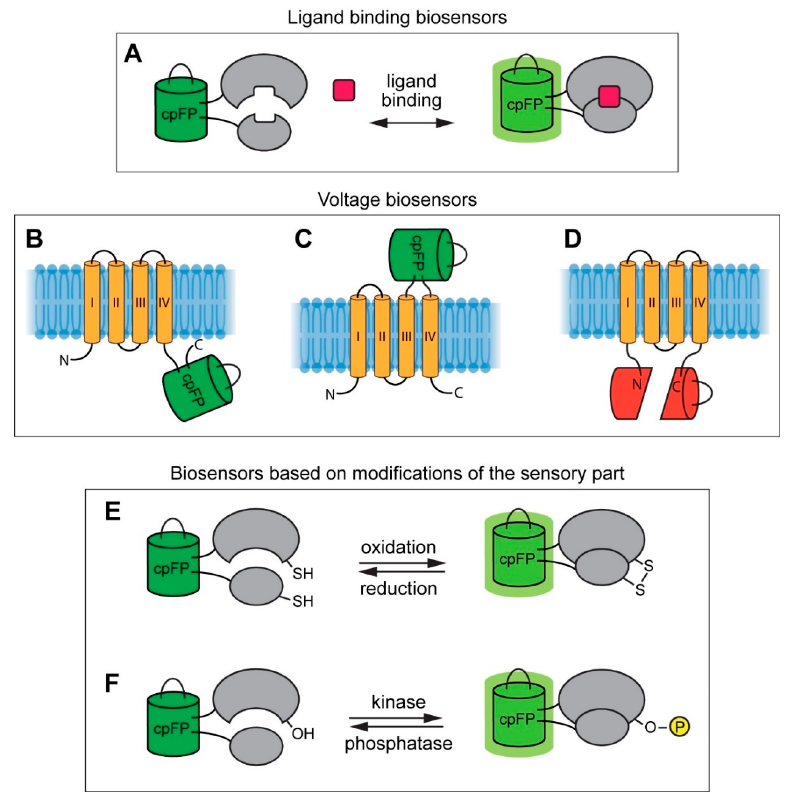
Figure 2. Main types of cpFP-based biosensors. ( A ) cpFP-based biosensors with sensory domains capable of ligand binding. ( B – D ) Voltage biosensors. The principle is based on the fact that membrane depolarization causes a movement in transmembrane voltage sensitive domain (VSD), which ultimately leads to conformational changes in a cpFP, changing its fluorescence intensity. cpFP may be ( B ) fused to the terminus of a VSD or ( C ) integrated into the region between transmembrane segments of a VSD. ( D ) N- and C-termini of VSD may be fused with a cpFP whose polypeptide chain is split into two parts. These separate parts form a mature protein. ( E , F ) cpFP-based biosensors with sensory domains capable of undergoing protein modifications: ( E ) oxidation, ( F ) phosphorylation.